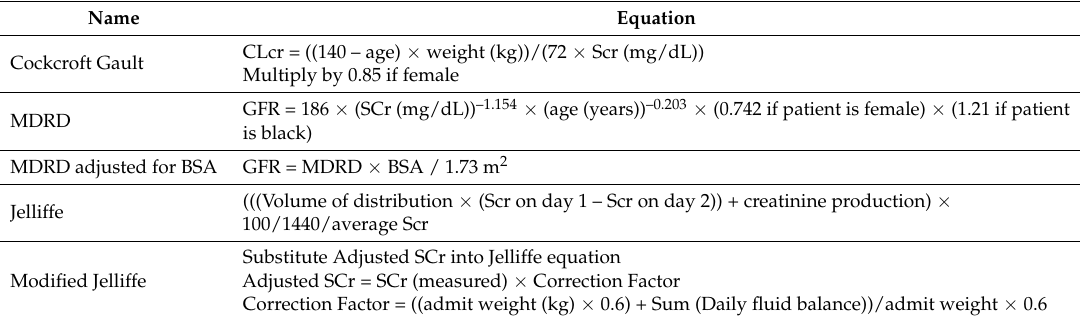
Table 1. Equations used to estimate renal